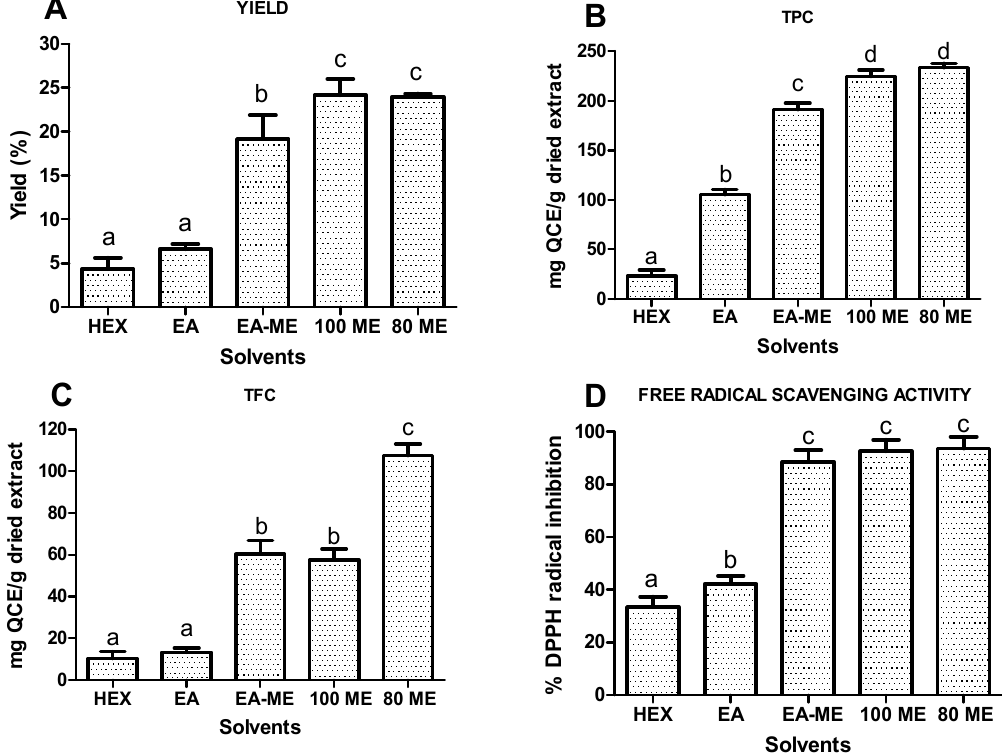
Figure 2. The effect of solvent on the extraction % yield ( A ), total phenolic content (TPC) ( B ), total flavonoid content (TFC) ( C ), and DPPH free radical scavenging activity ( D ) from OPLs. HEX, hexane; EA, ethyl acetate; EA–ME, 1:1 ethyl acetate–methanol; 100 ME, absolute